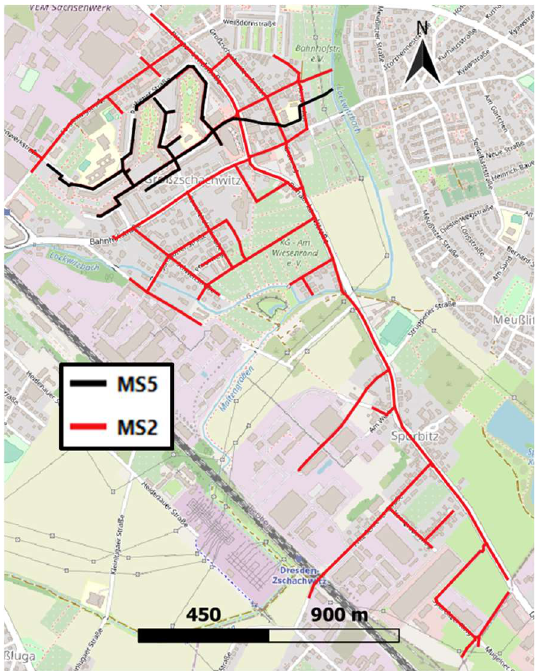
Figure 1. Combined (MS2) and separate (MS5) sewer networks in the study area.